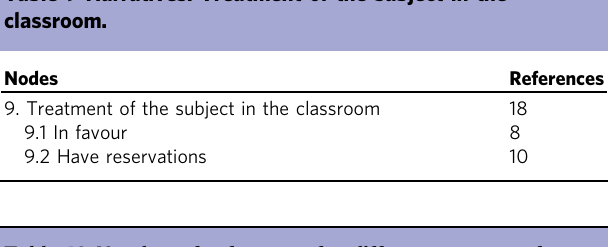
Table 10 Number of references for different sources of information.